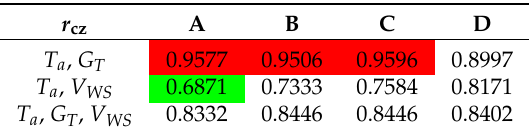
Table 5. The r cz values in four GWCs. The highest values are in red boxes and the lowest values are in